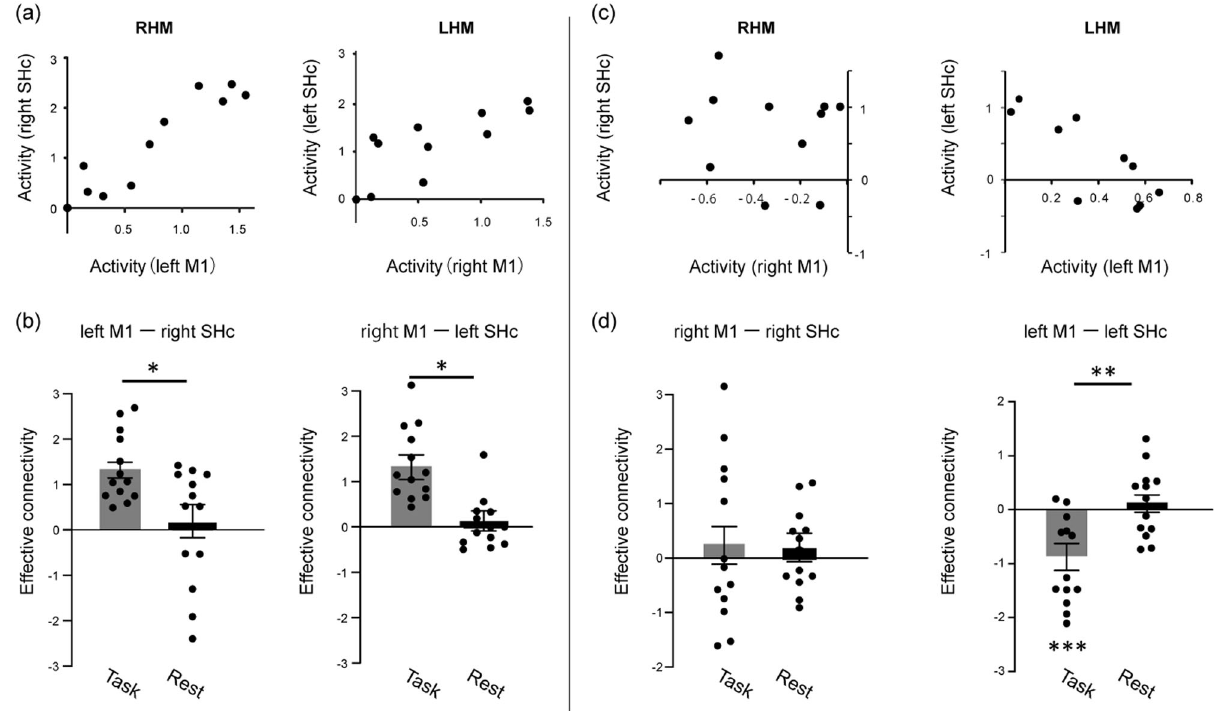
Fig. 1 Asymmetric recruitment of the ipsilateral corticospinal network during hand movement. a Correlation between activity in contralateral M1 ( x -axis) and ipsilateral SHc ( y -axis) during RHM (left panel) or LHM (right panel) in a representative participant. Dots indicate the mean activity at each time point during hand movements. b Effective connectivity (contralateral M1 – ipsilateral SHc) for RHM and LHM during the task and during rest periods. * p < 0.001. c Correlation between ipsilateral M1 activity ( x -axis) and ipsilateral SHc activity ( y -axis) in the same representative participant. d Effective connectivity (ipsilateral M1 – ipsilateral SHc) for RHM and LHM during the task and rest periods (** p = 0.03, *** indicates p = 0.01).